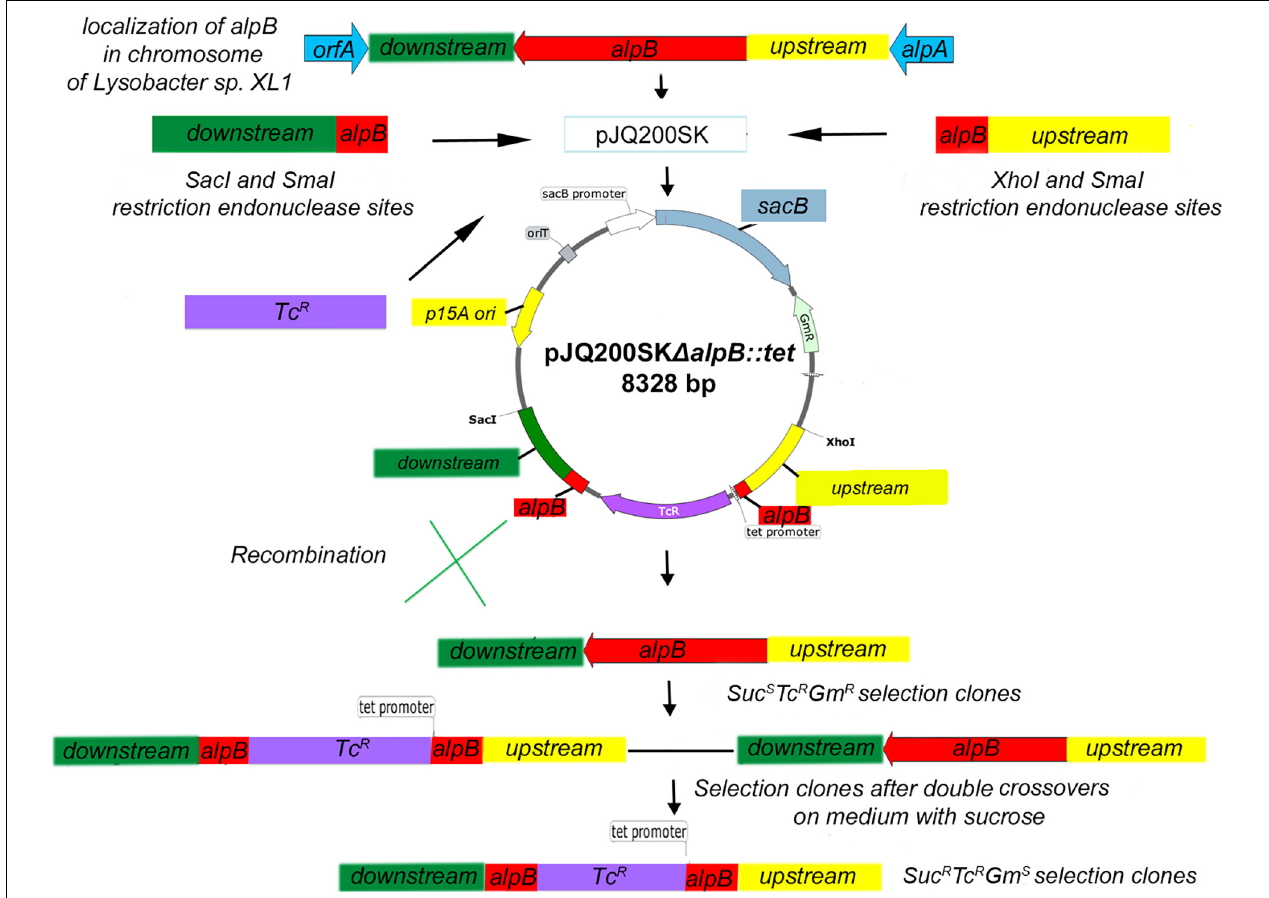
FIGURE 1 | Scheme of inserting a mutation into the alpB gene of Lysobacter sp. XL1. The pJQ200SK (cid:49) alpB::tet recombinant plasmid was introduced into cells of Lysobacter sp. XL1 via electroporation. Integration of the plasmid into the chromosome was testified by the resistance of transformants to gentamicin (plasmid marker) and tetracycline (cassette marker inserted into the deletion locus) and by the sensitivity to sucrose. As a result of merodiploid resolution, Suc R Tc R Gm S clones with double crossovers between the mutant and wild-type alleles of the alpB gene were